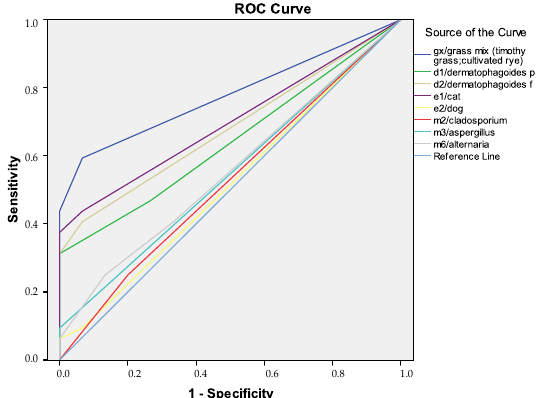
Figure 6. ROC curve for assessing the specificity and sensitivity of EUROIMMUN aero (distinct sIgE) vs. ImmunoCAP Phadiatop.